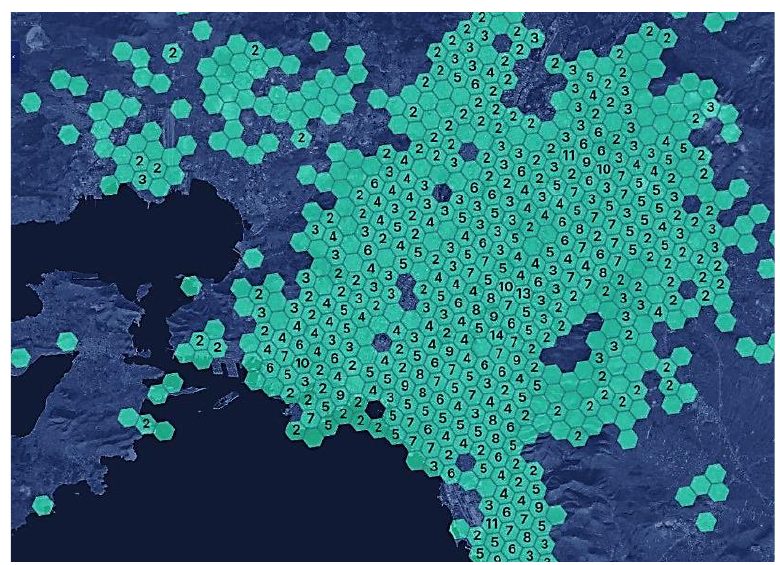
Figure 16. Helium Hotspots in Attica.